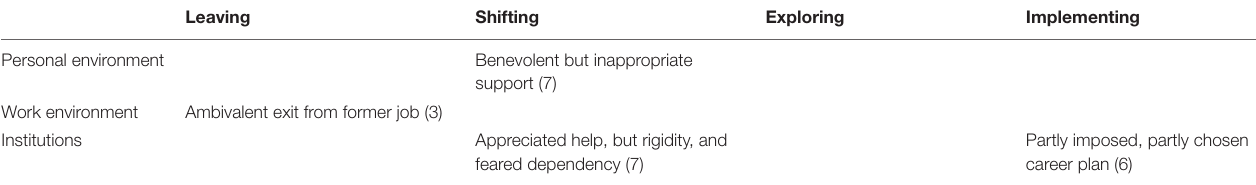
TABLE 4 | Subthemes within ambivalent relational influences. Leaving Shifting